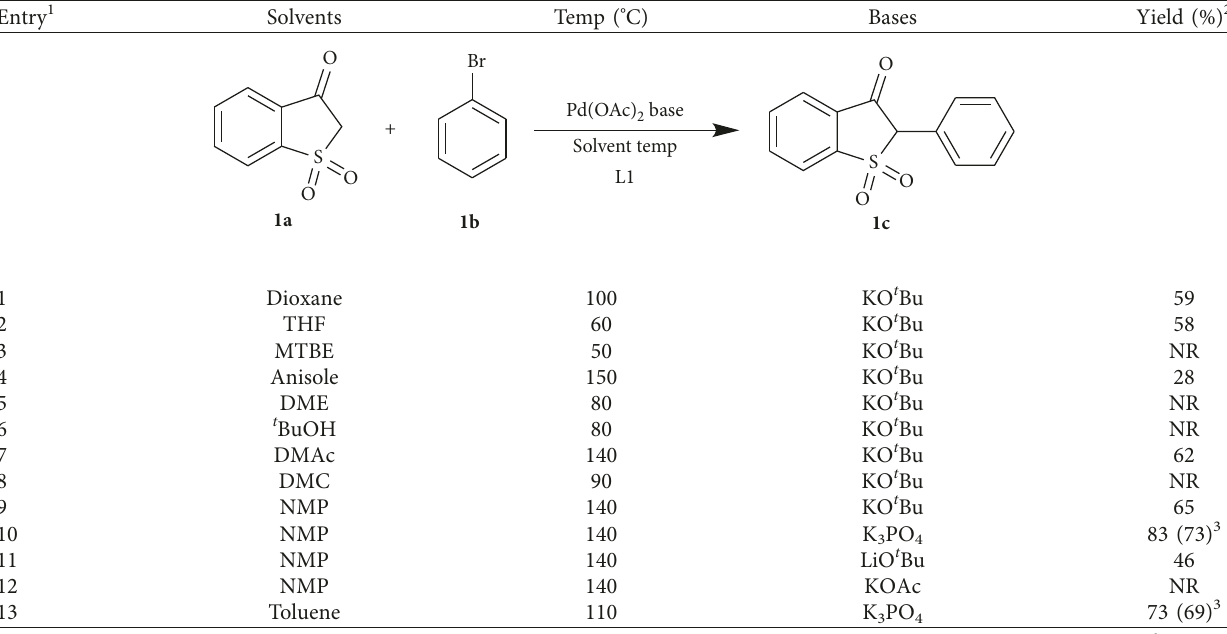
Table 2: Optimization of solvents and